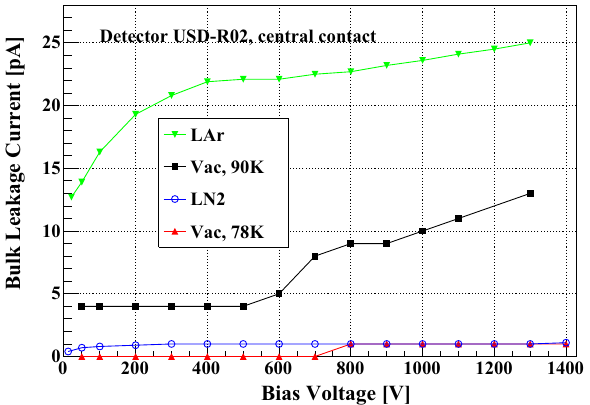
Fig. 18 LargestleakagecurrentsofdetectorUSD-R02invariousenvi- ronments through its central contact